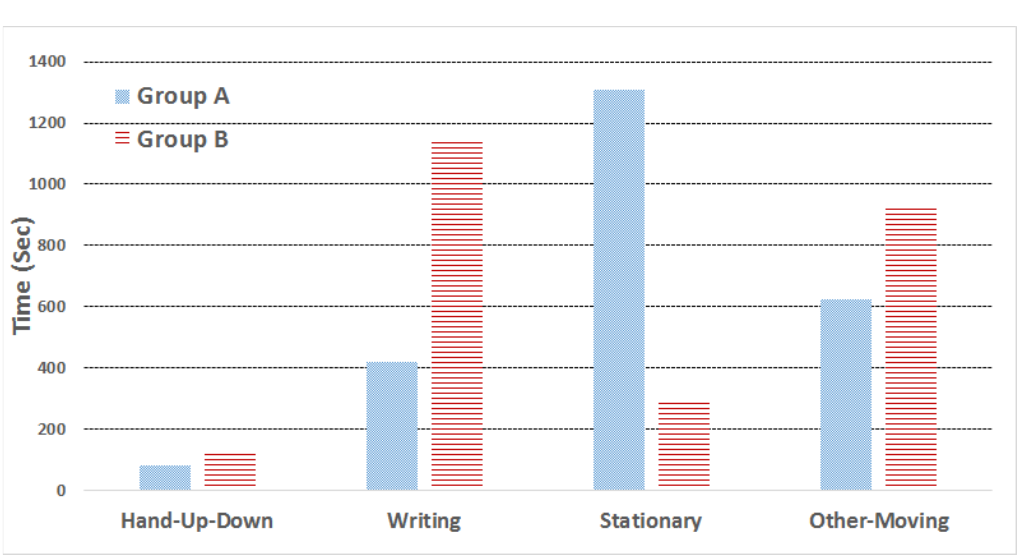
Figure 8. Average duration of the four basic